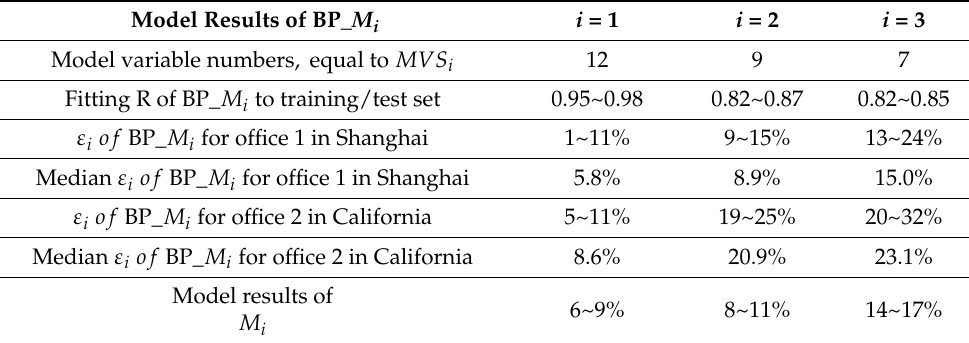
Figure 4. Fitting results of the developed BP ANN model for training, validation and test sets. Table 5. Predictive error comparison of BP ANN models for actual